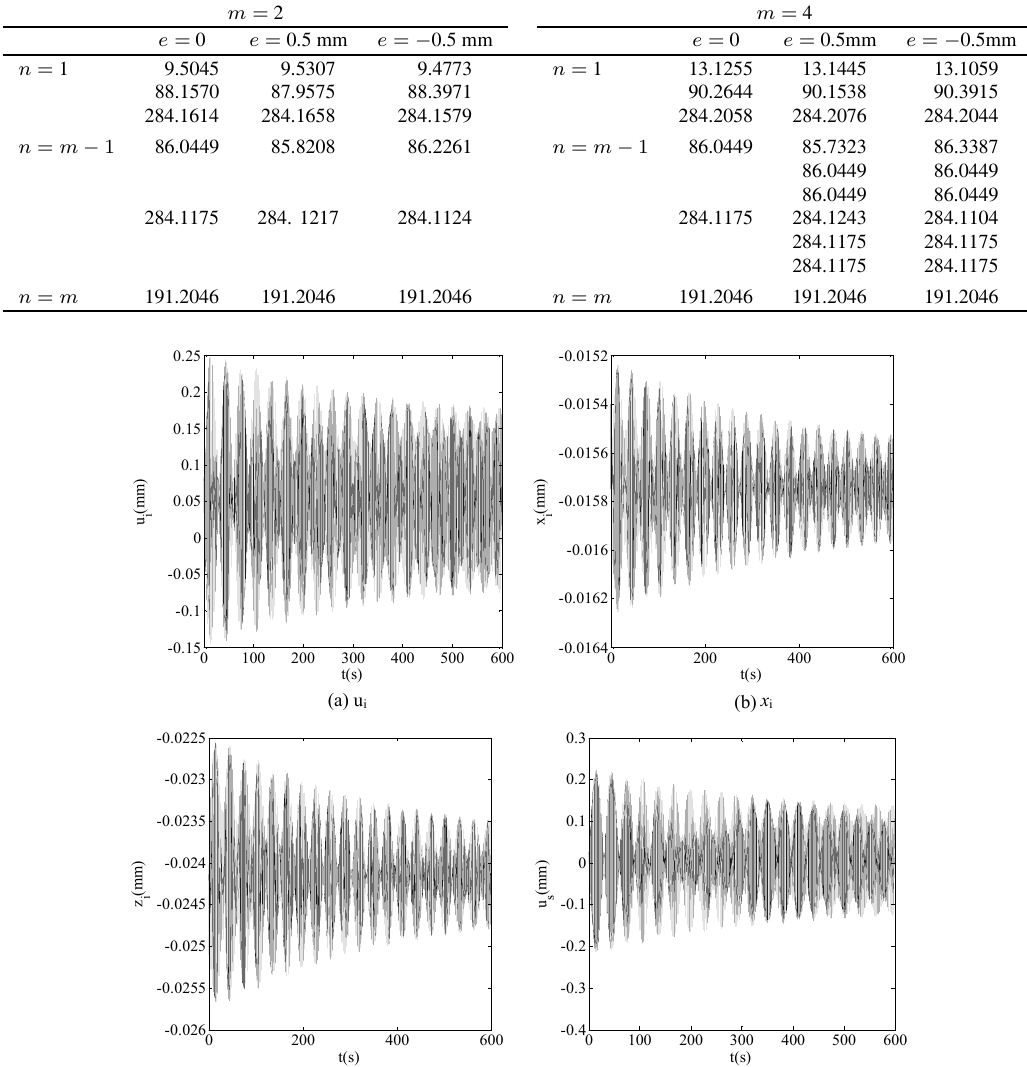
Table 5 Natural frequencies of the drive system with eccentric center planet (rad/s)